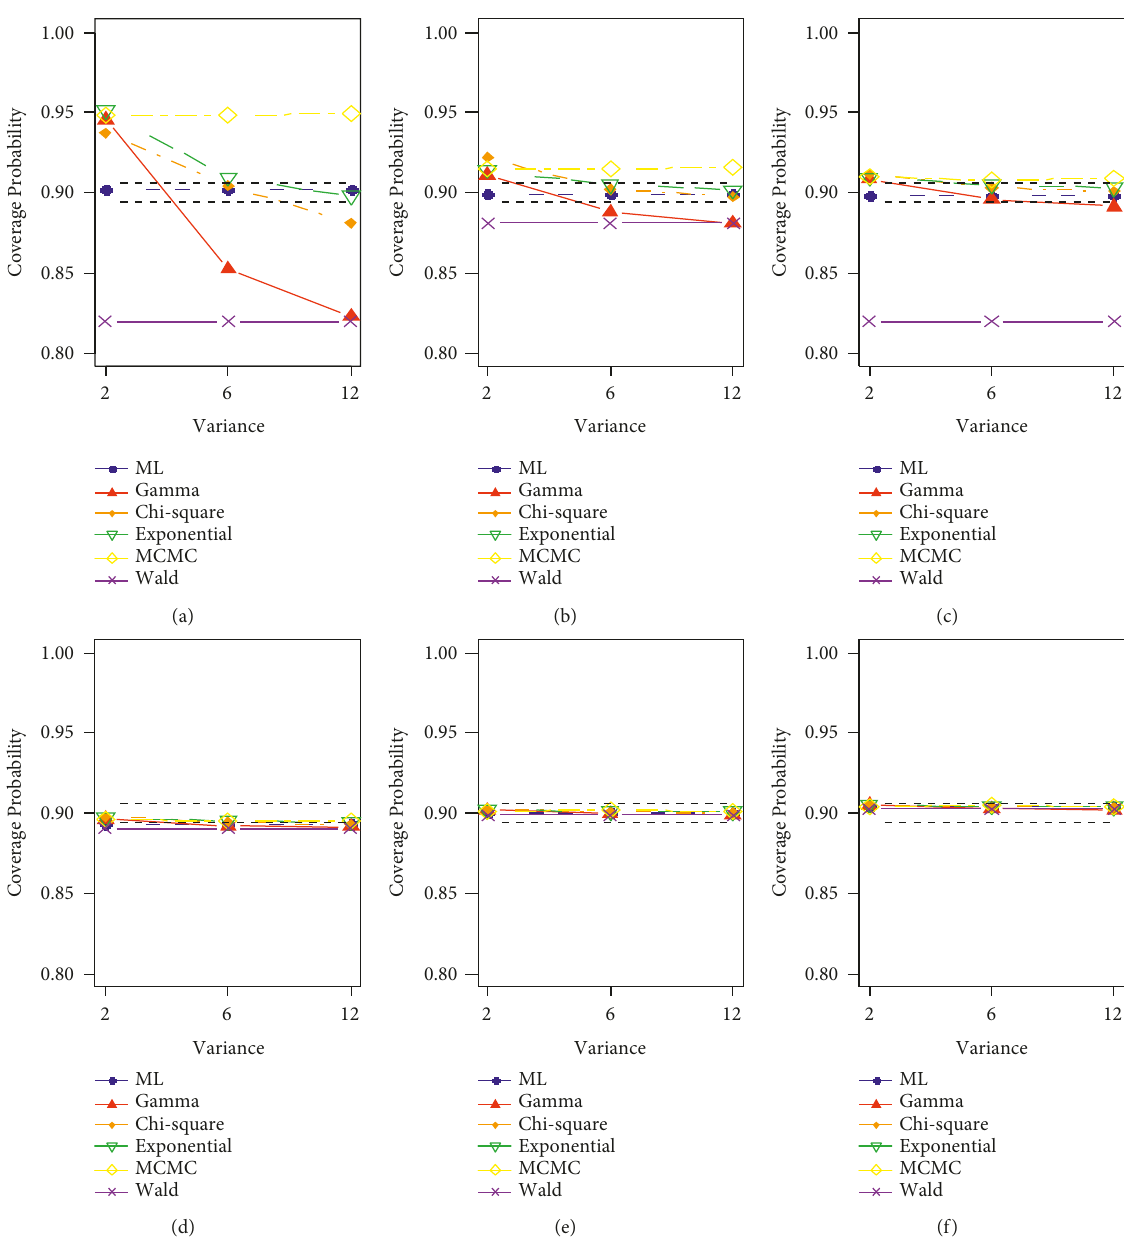
Figure 4: The trend of CP for all methods varies by variance at 90% confidence interval. (a) n � 10. (b) n � 50. (c) n � 100. (d) n � 300. (e) n � 500. (f) n �